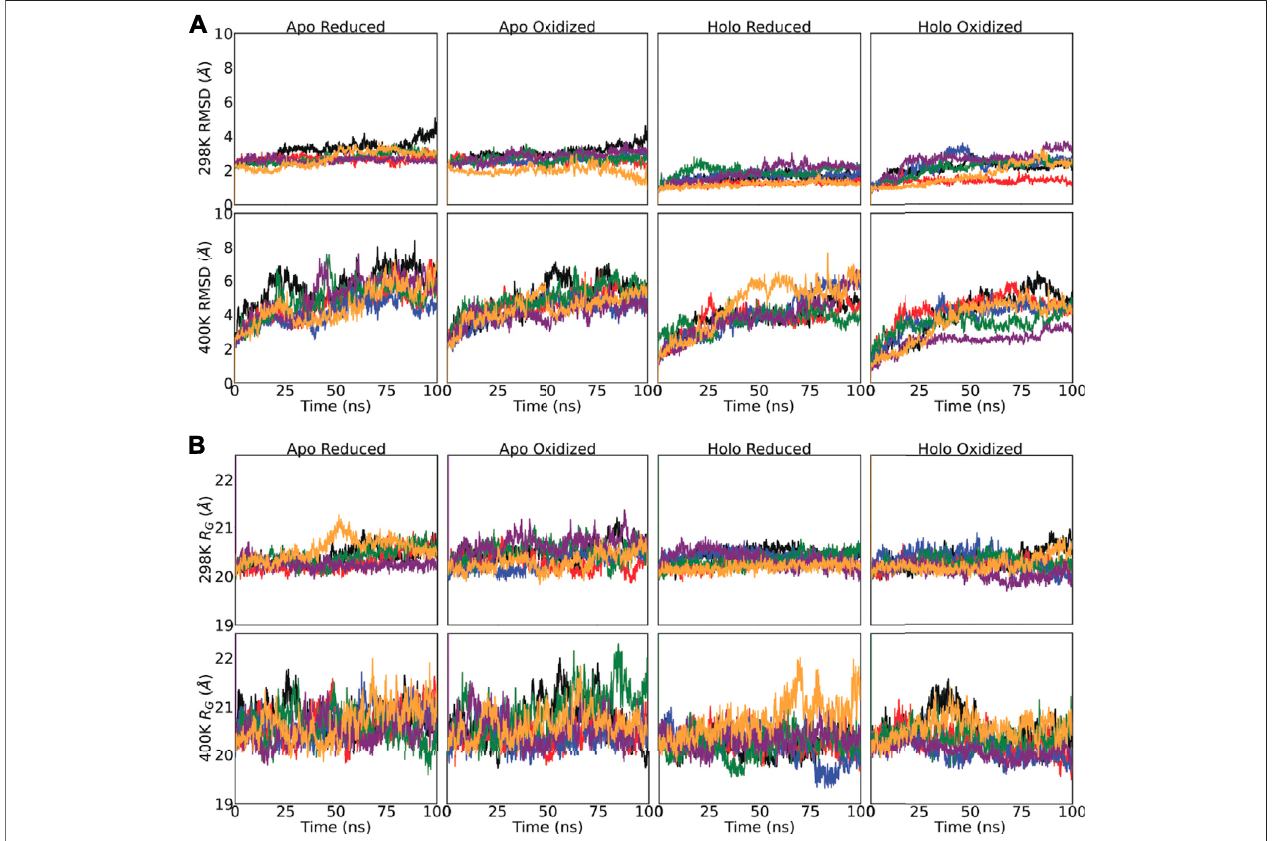
FIGURE 3 | (A) Backbone (C α , C, O and N) displacement and (B) radius of gyration ( R G ) of the SOD1 dimers were monitored for 100 ns For both sub-plots, top- panel shows the 298 K and bottom-panel shows 400 K simulations. The same legend applies for all subplots: Wild-type-black, H63A-red, H63R-blue, K136A-green, G37R-purple,